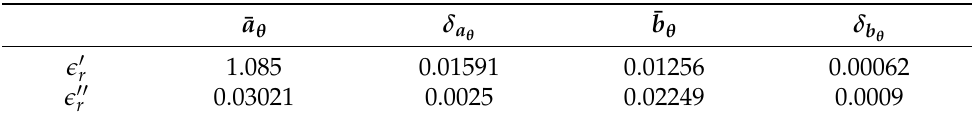
Table 1. Material model